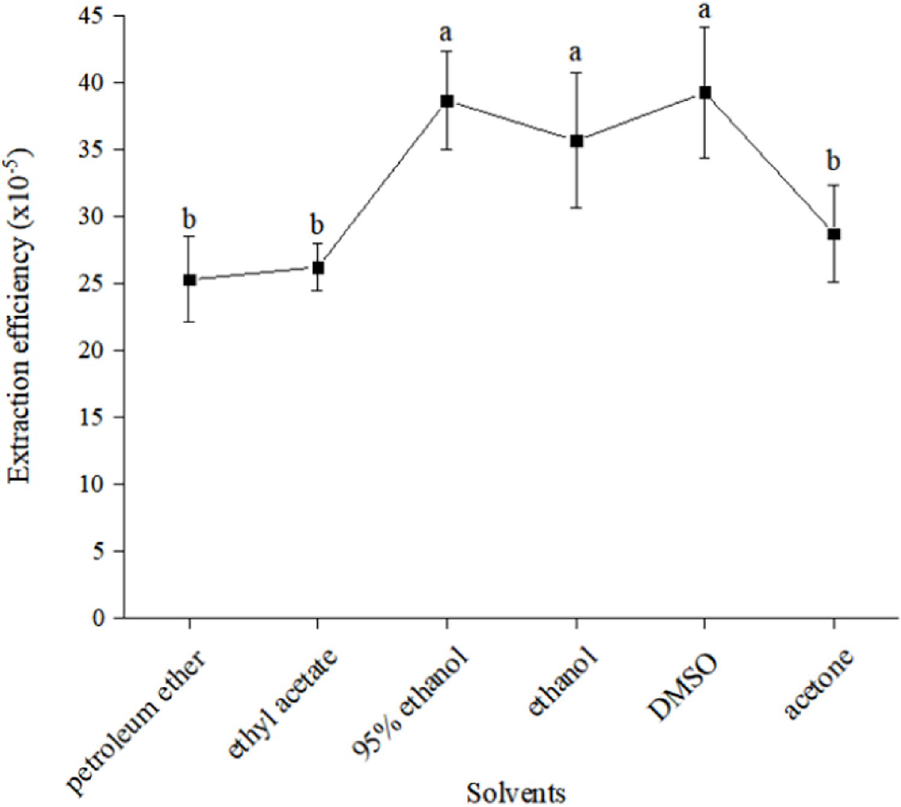
Fig 1. Effects of different solvents on extraction efficiency of carotenoids. Two items with same letter have no significant difference. Two items with different letter have significant difference.